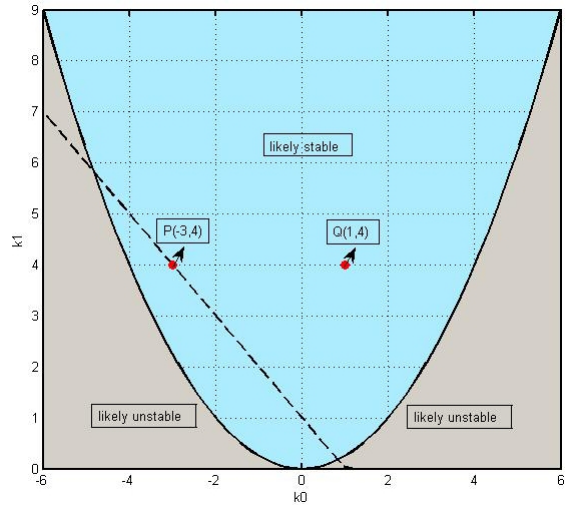
Fig. 2. Different regions of k 1 (cid:0) k 0 plane for possibly stable choices of C and its stable subsystems A; B .